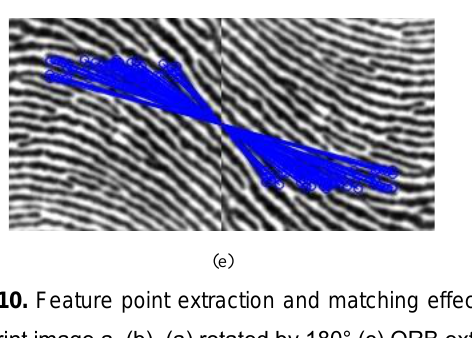
Figure 9. Self-built database fingerprint image (160×160 pixels)